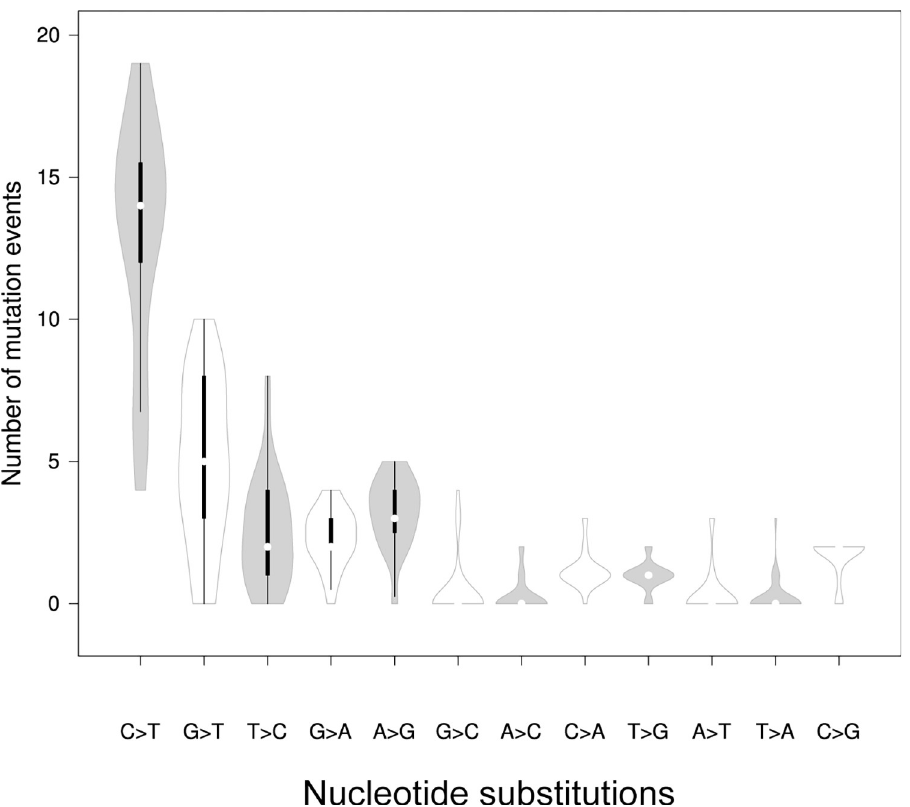
Fig 4. Box plot of distribution of single nucleotide substitutions per genome among the SARS-CoV-2 isolates (n = 39) in Uzbekistan. The cross marks the mean values, the bold line marks median.